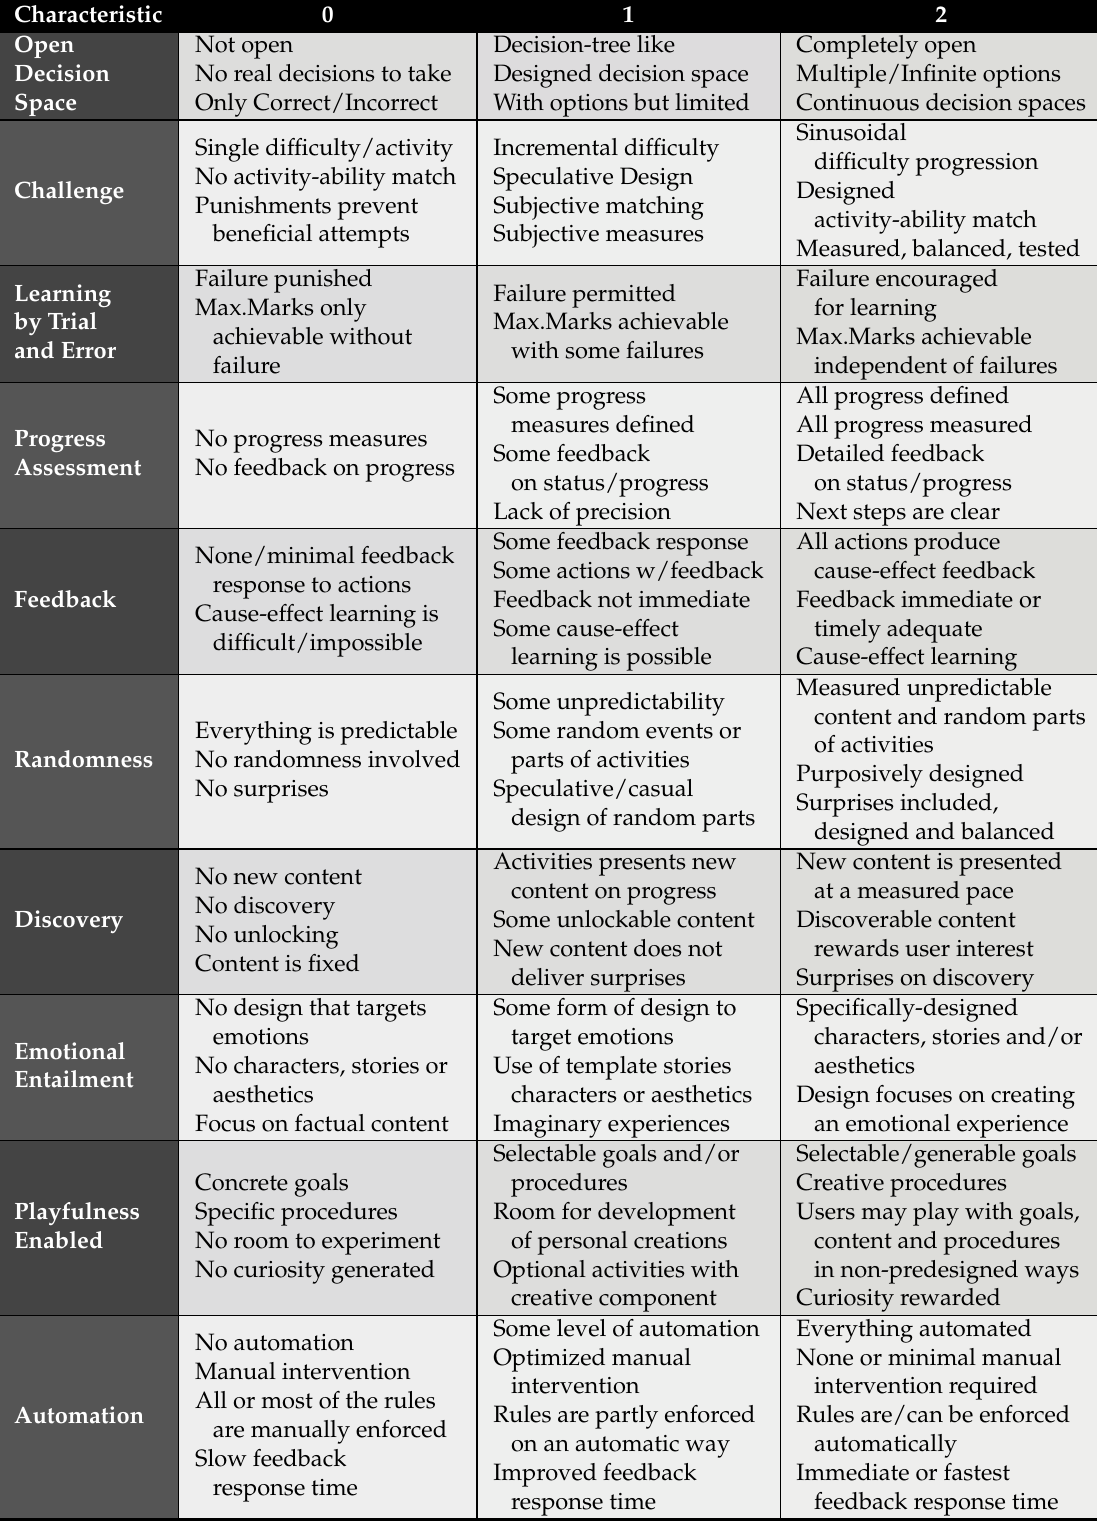
Table 1. Ten-characteristic game-design-based gamification